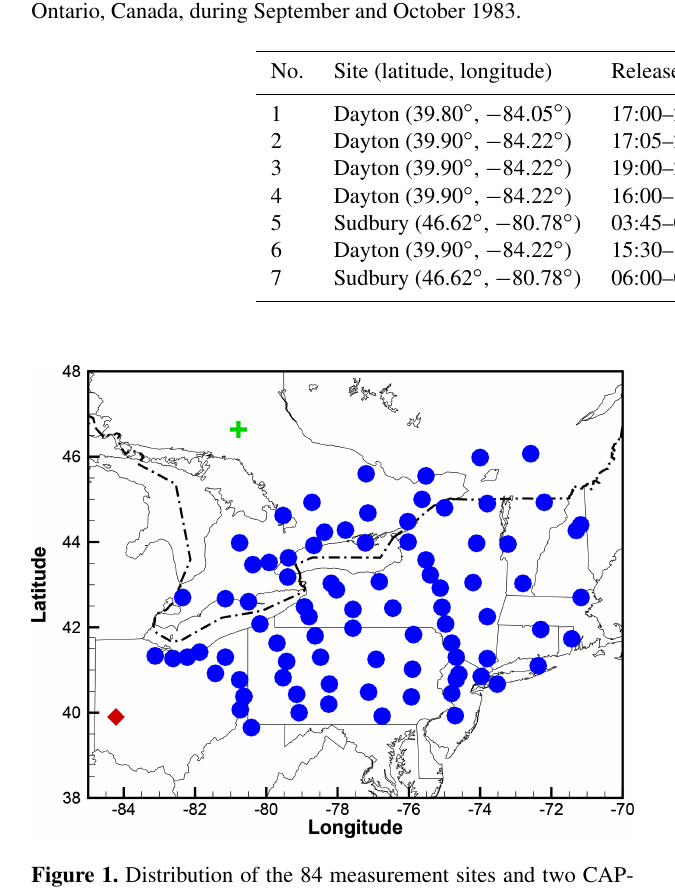
Table 1. The locations, time, amounts, and measurement counts ( M obs ) of each CAPTEX release from Dayton, Ohio, USA, and Sudbury, Ontario, Canada, during September and October 1983.